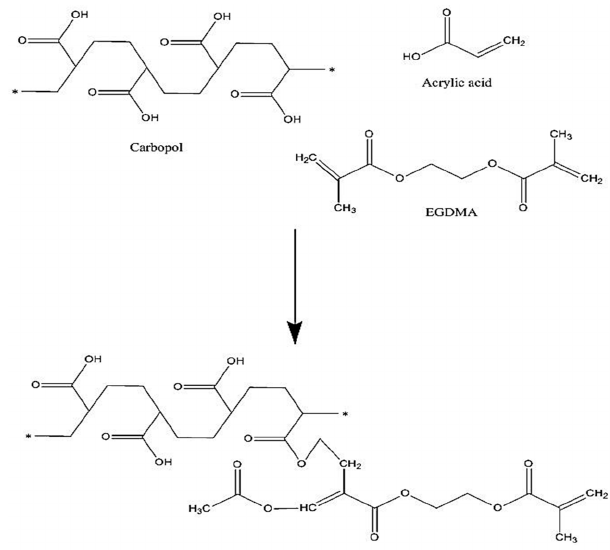
Figure 1. Proposed chemical structure of Car934-g-poly(acrylic acid) hydrogels. Pharmaceuticals 2020 , 13 , x FOR PEER REVIEW